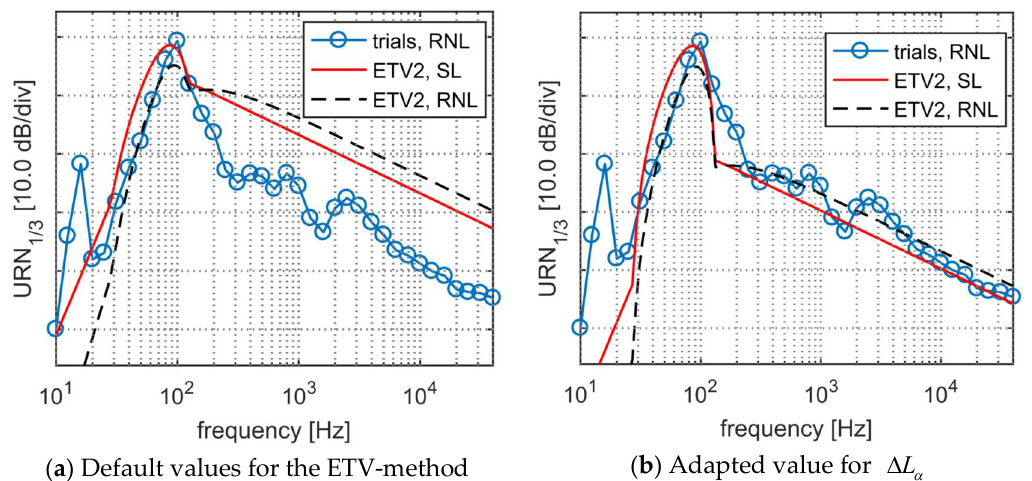
Figure 15. Measured and predicted radiated noise spectrum in one-third octave band levels for the combi-freighter at a ship speed of 10 knots. Experimental data by DNV-GL.